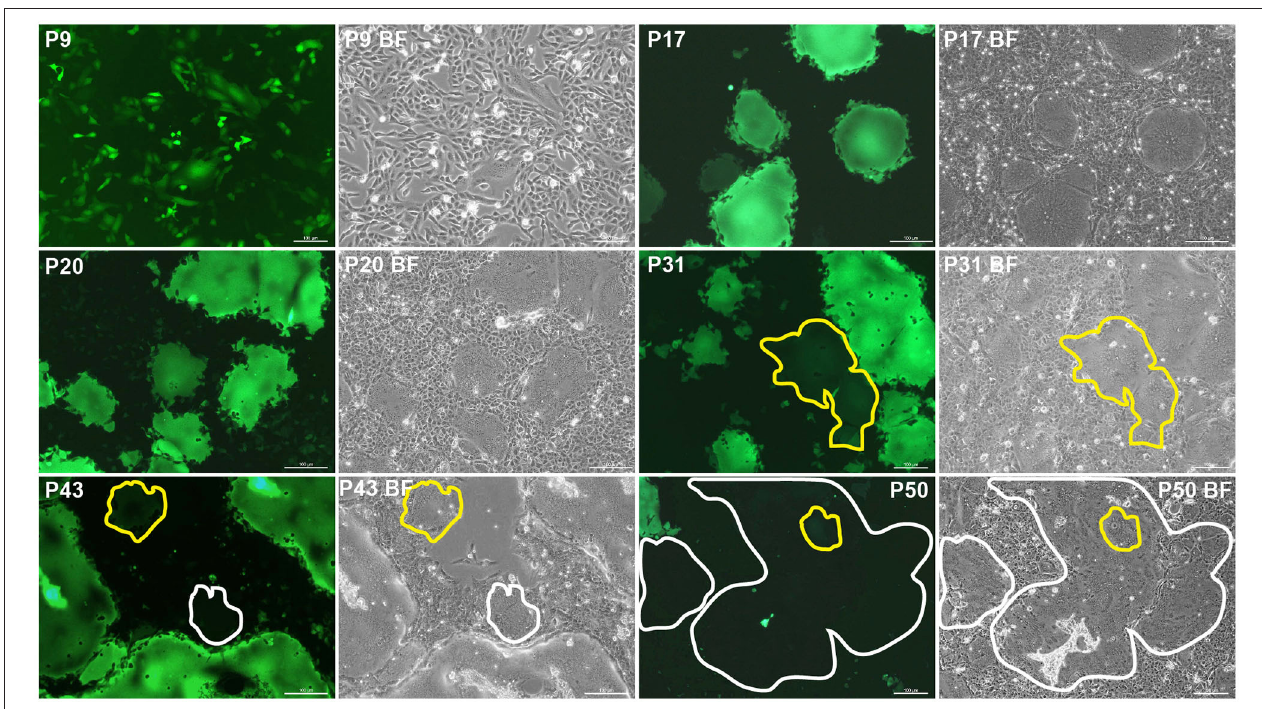
FIGURE 1 | Fluorescence-attenuated or -disappeared syncytia formation during 45 serial passages in ribavirin-treated VDS cells. Fluorescence-attenuated and -disappeared syncytia are enclosed by yellow and white lines, respectively. BF, bright